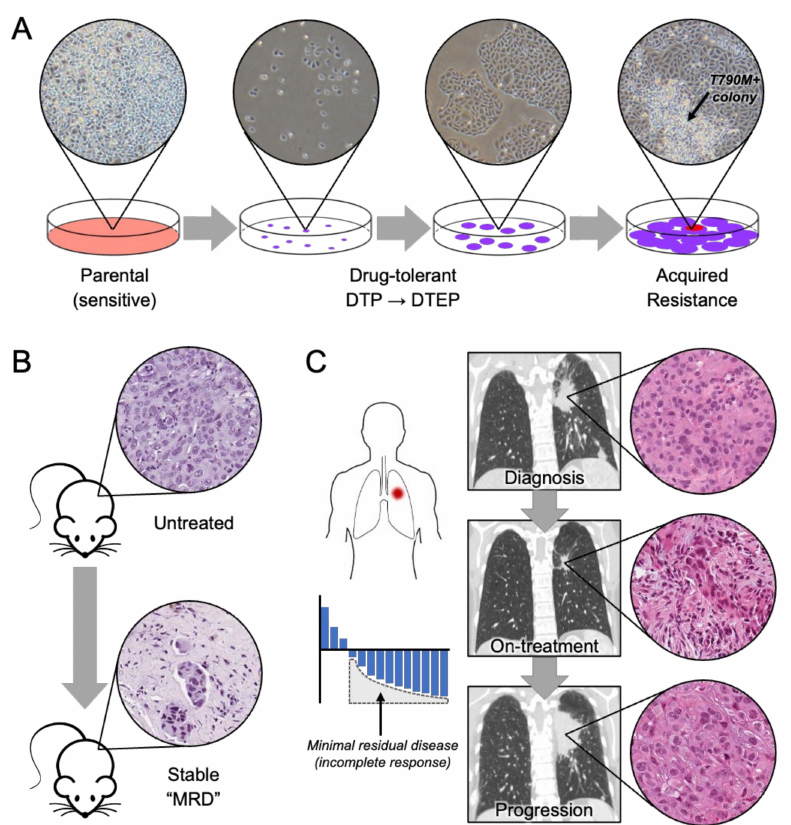
Figure 3. Studying persisters in cancer. ( A ) Modeling persisters using in vitro cell culture systems. Persisters are modeled by a sub-population of cells that remain viable in culture upon extended drug treatment after the majority of sensitive parental cells are eliminated. PC9 EGFR-mutant lung cancer cells are shown before (left) and during gefitinib treatment. Over time, the population of drug-tolerant persisters (middle images) gives rise to a fully resistant T790M+ clone (right image). ( B ) Modeling persisters in vivo using mouse xenograft tumors. Drug treatment leads to tumor regression followed by a period of stable “minimal residual disease” (MRD) in which a small population of cancer cells exist within tumors that are no longer regressing. Shown are H&E images of EGFR-mutant lung cancer patient-derived xenograft tumors before or after treatment with osimertinib, revealing small residual clusters of surviving tumor cells. ( C ) Studying persisters in the clinic. As illustrated by a typical waterfall plot of best tumor response, most patients do not experience complete responses to targeted therapies. Residual disease lesions harbor surviving cancer cells but may remain stable for months or even years. Sequential pre/on-treatment and progression biopsies enable study of persister phenotypes and the evolutionary trajectories of resistant cancer cells. H&E images depict sequential biopsies from an EGFR lung cancer patient treated with EGFR targeted therapy in a clinical trial. In the on-treatment biopsy, small clusters of tumors cells are surrounded by extensive fibroblastic